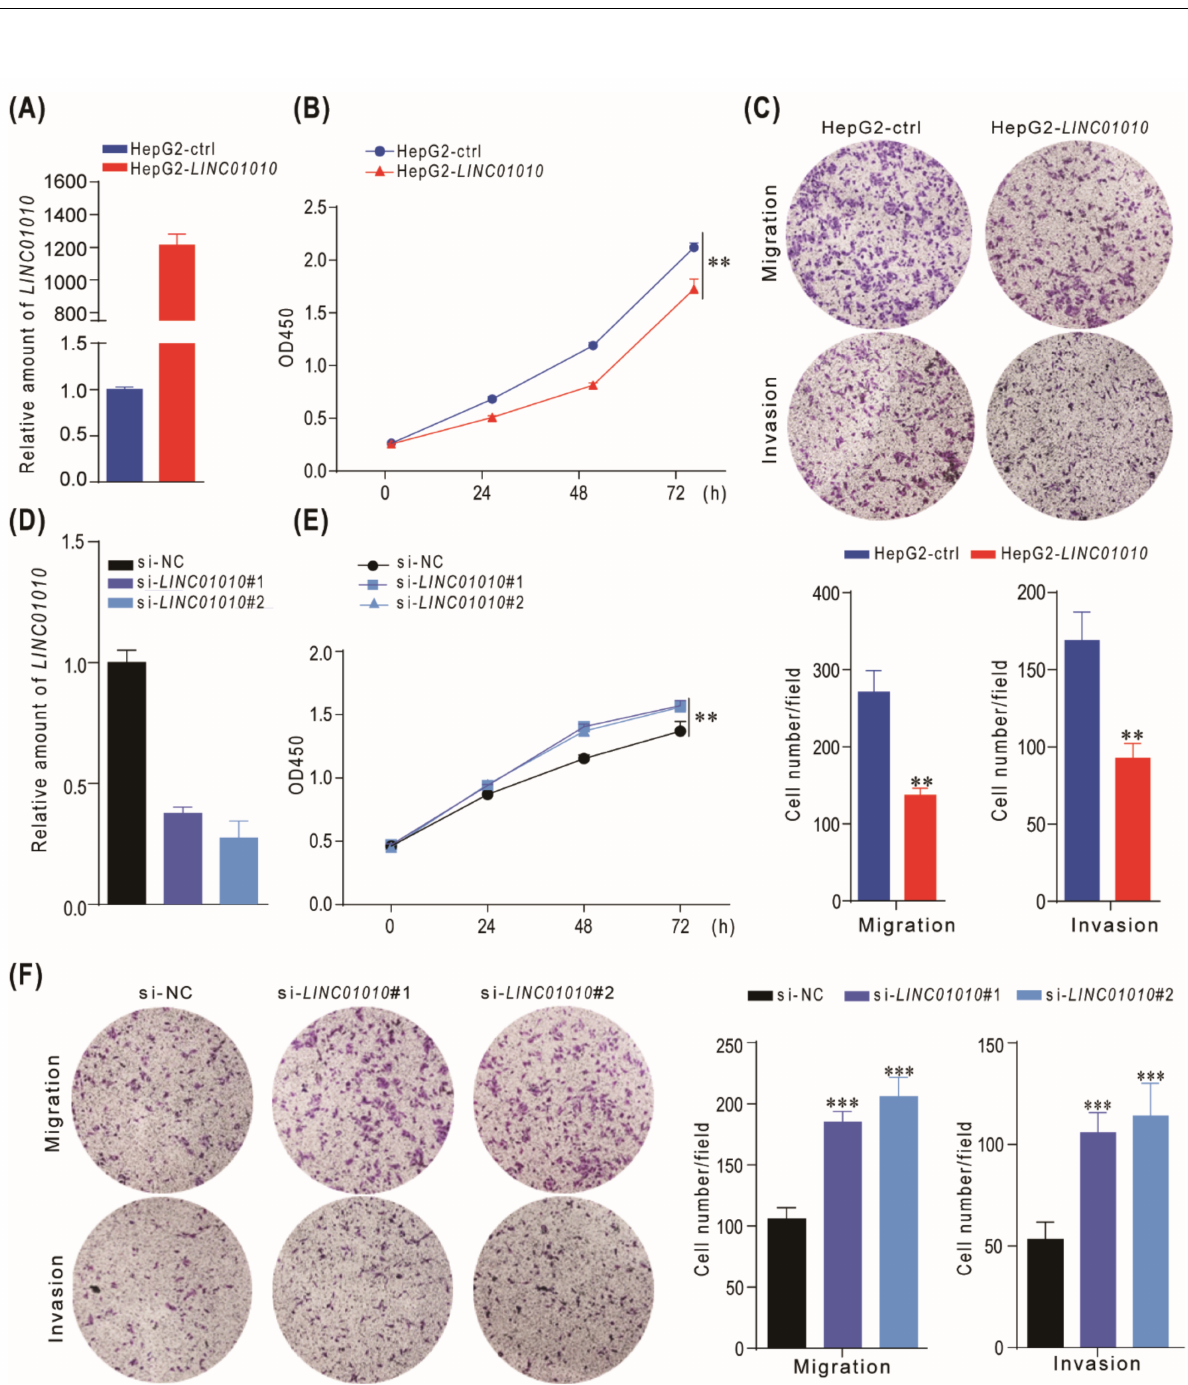
Figure 2. LINC01010 inhibits HCC cell proliferation, migration and invasion. ( A ) HepG2 cells were infected with lentivirus carrying LINC01010 or control lentivirus. The relative level of LINC01010 was quantified by real-time PCR. ( B ) The growth curve of HepG2 overexpressing LINC01010 or control cells were performed by CCK-8 assay. ( C ) The migration and invasion of LINC01010 -overexpressed HepG2 or control cells were determined by transwell assay. The representative of migration and invasion assays (top panels) and the corresponding statistical results (bottom panels) are shown. A total of 4 × 10 4 cells were used for migration assay, and 8 × 10 4 cells were used for invasion assay. ( D ) The siRNAs targeting LINC01010 (si- LINC01010 #1, si- LINC01010 #2) or control siRNA were transfected into HepG2 cells for 48 h. Then, the total RNA was extracted and subjected to real-time PCR. ( E ) HepG2 was transfected with si-RNAs of LINC01010 and then subjected to CCK8 assay. ( F ) The migration and invasion of LINC01010 knockdown HepG2 cells and control cells were measured by transwell assay. The representative images (left panels) and the corresponding statistical results (right panels) are shown. A total of 3 × 10 4 cells were used for migration assay, and 6 × 10 4 cells were used for invasion assay. ** p < 0.01, *** p < 0.001, means ± SD are